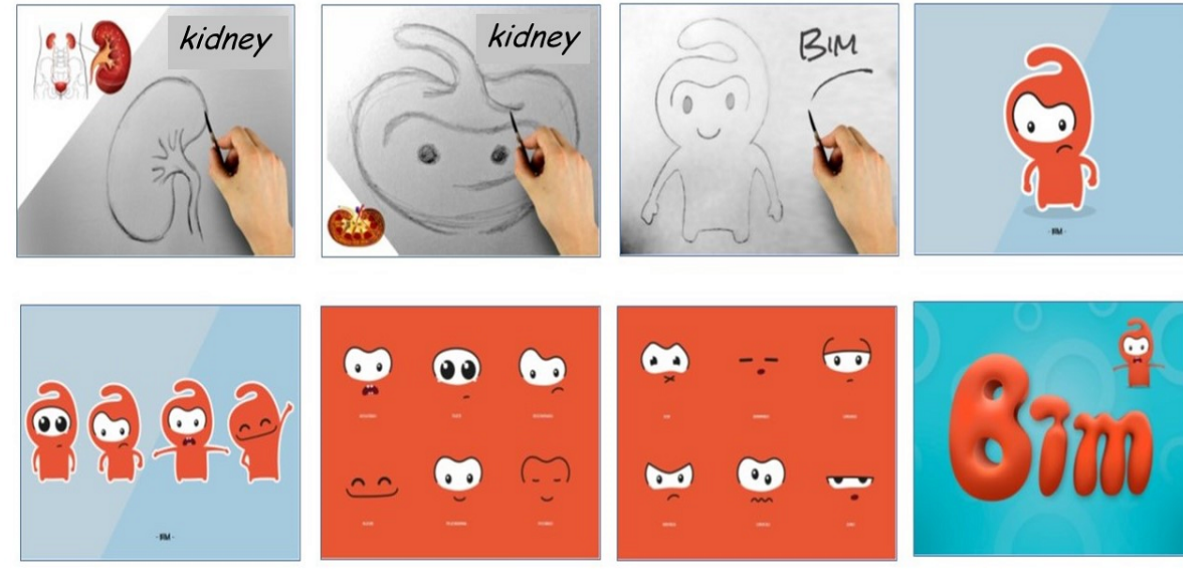
Figure 1. Process of creating the character, which resembles a kidney. The various expressions are meant to corroborate with the player's perception of the character's emotions while performing an action in the game.